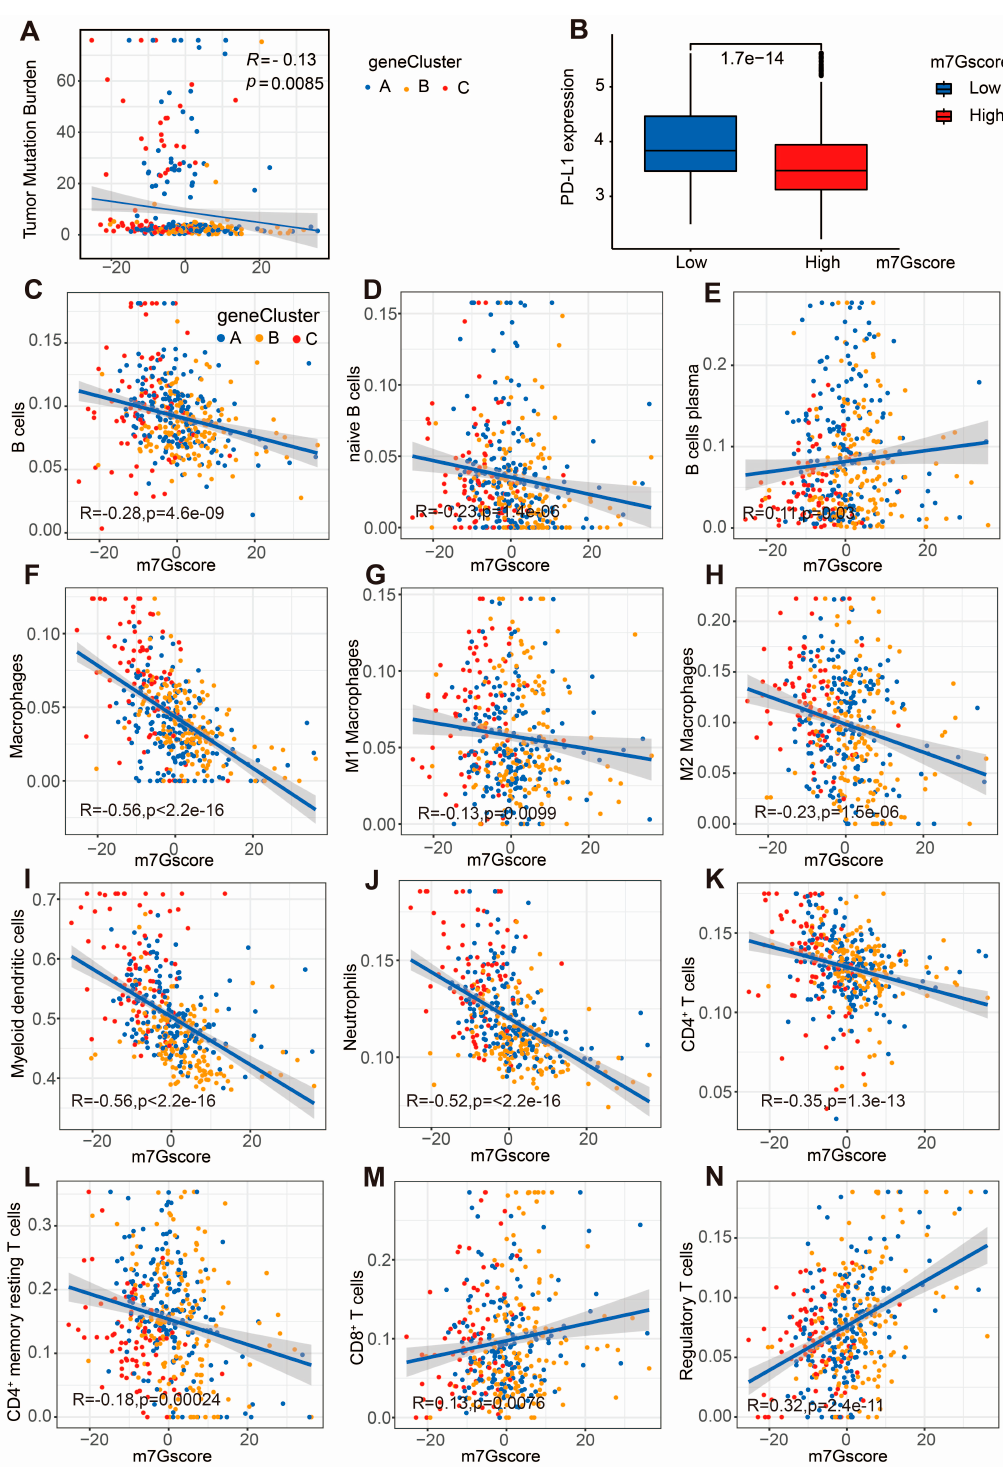
Figure 9. Correlation analysis between m7G score and TMB, as well as tumor immune microenvi- ronment. ( A ) Relevance of TMB and m7G score in CC patients. ( B ) Expression level of immune checkpoint PD-L1 in CC patients from high- and low-m7G score groups. ( C – N ) Correlation analysis between infiltration levels of B cells ( C ), naive B cells ( D ), B cells plasma ( E ), Macrophages ( F ), M1 Macrophages ( G ), M2 Macrophages ( H ), Myeloid dendritic cells ( I ), Neutrophils ( J ), CD4+ T cells ( K ), CD4+ memory resting T cells ( L ), CD8+ T cells ( M ), regulatory T cells ( N ) and m7G